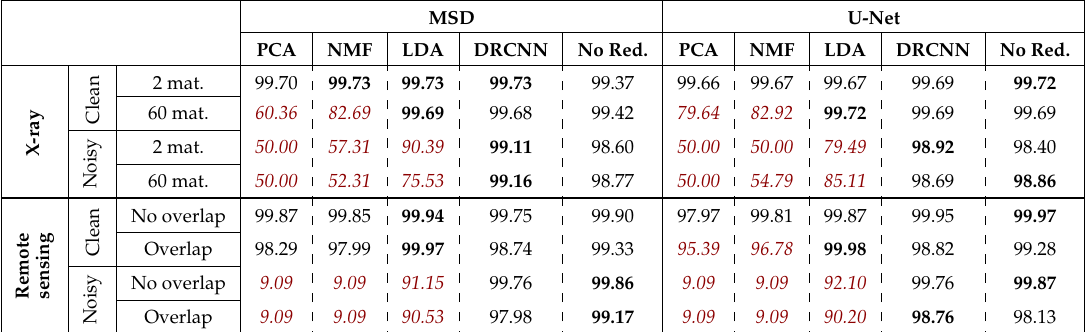
Table 1. Average class accuracies for various datasets and data reduction methods for reductions to two feature map channels (except for Linear Discriminant Analysis (LDA) on the X-ray dataset, which is reduced to one feature map channel, since there are only two target labels). Accuracies below 97.5% are indicated in italic red, and the highest value(s) per row for each dataset and CNN are indicated in